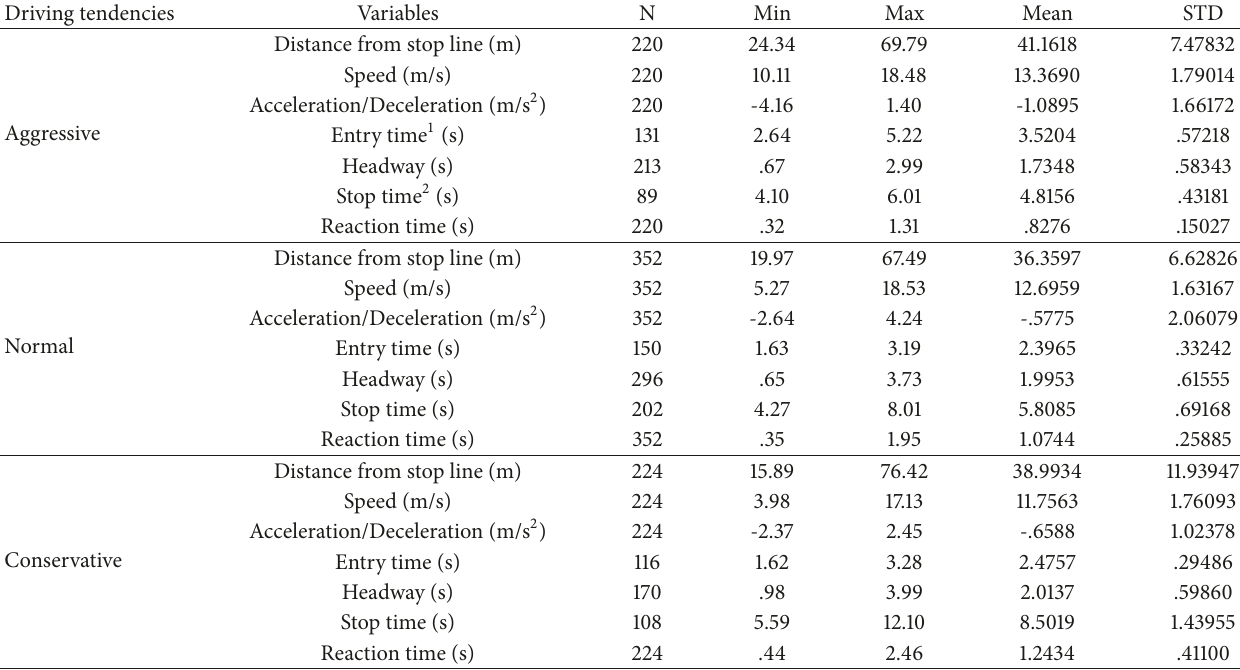
Table 1: Statistical results of driving variable parameters of different driving